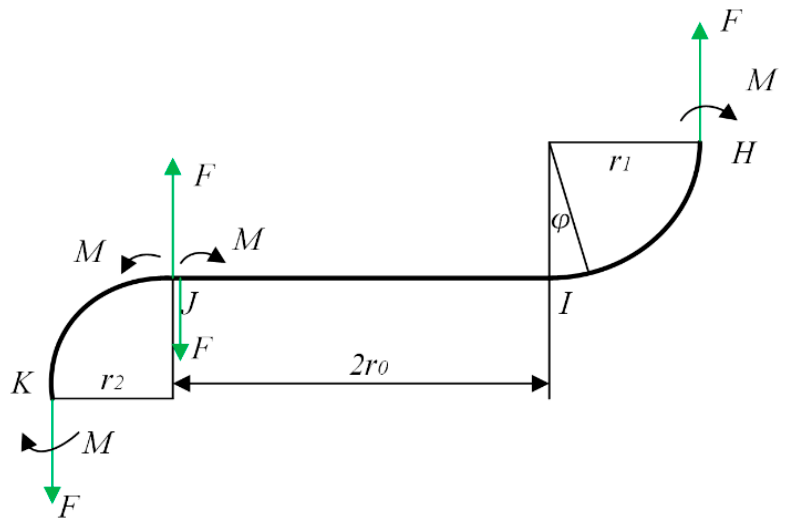
Figure 7. Force diagram of the half wave.